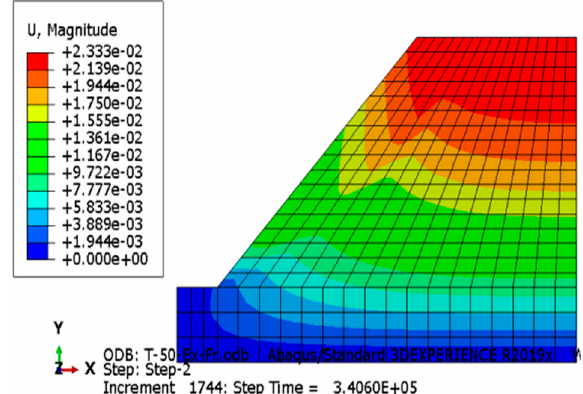
Figure 10. Displacement cloud diagram when slope is unstable after 50 freeze–thaw cycles .